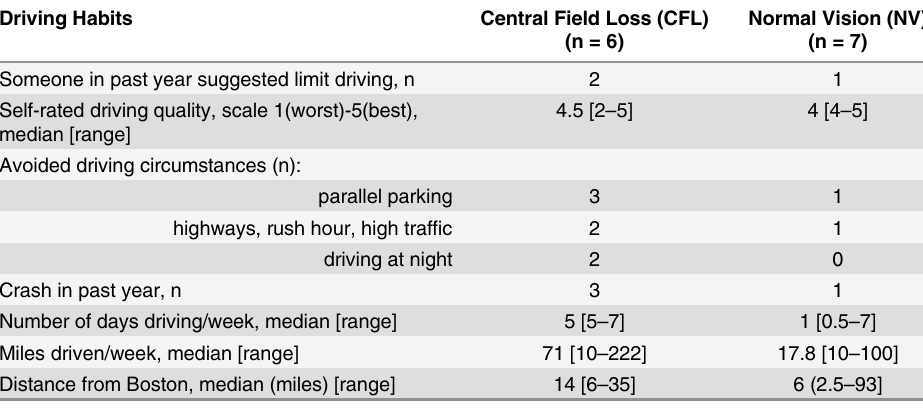
Table 2. Driving Habits Questionnaire summary for current drivers. Driving